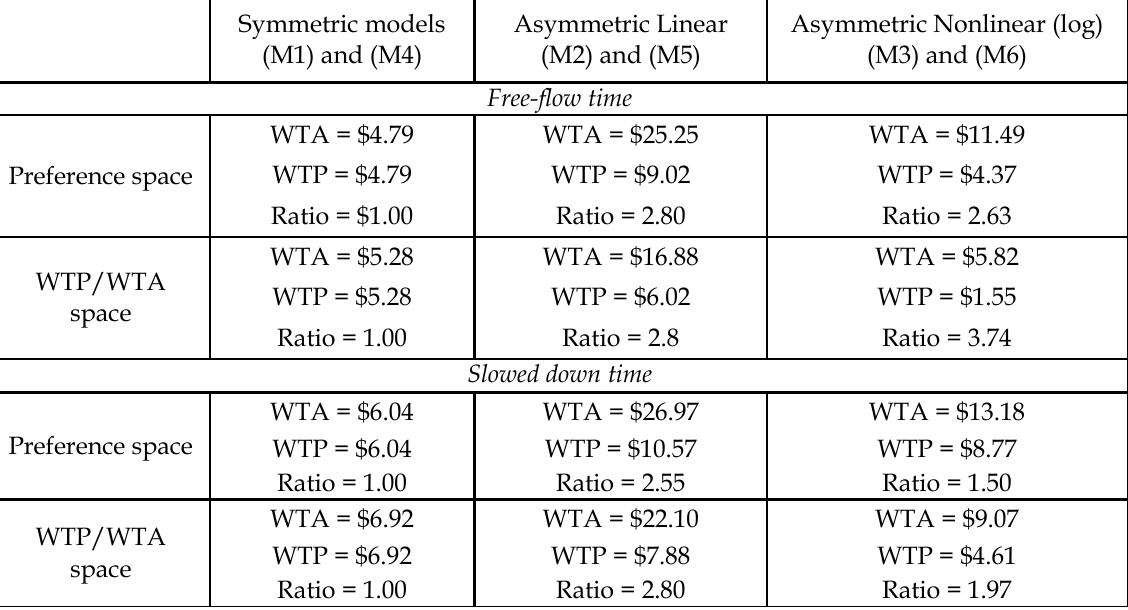
Table 4. WTP/WTA results (AUD/min, normalized at 20